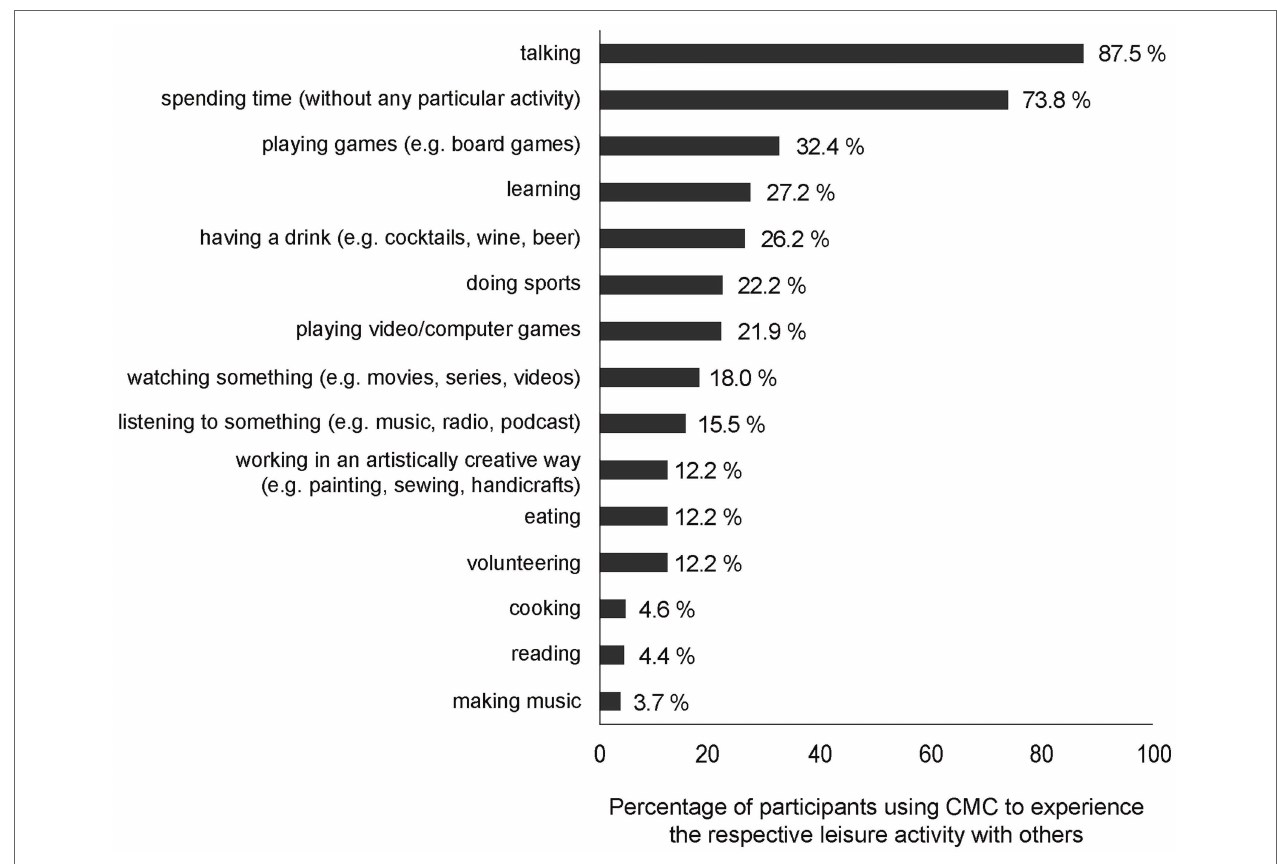
FIGURE 2 | Percentage of participants who reported experiencing certain leisure activities together with others via CMC during the first nationwide